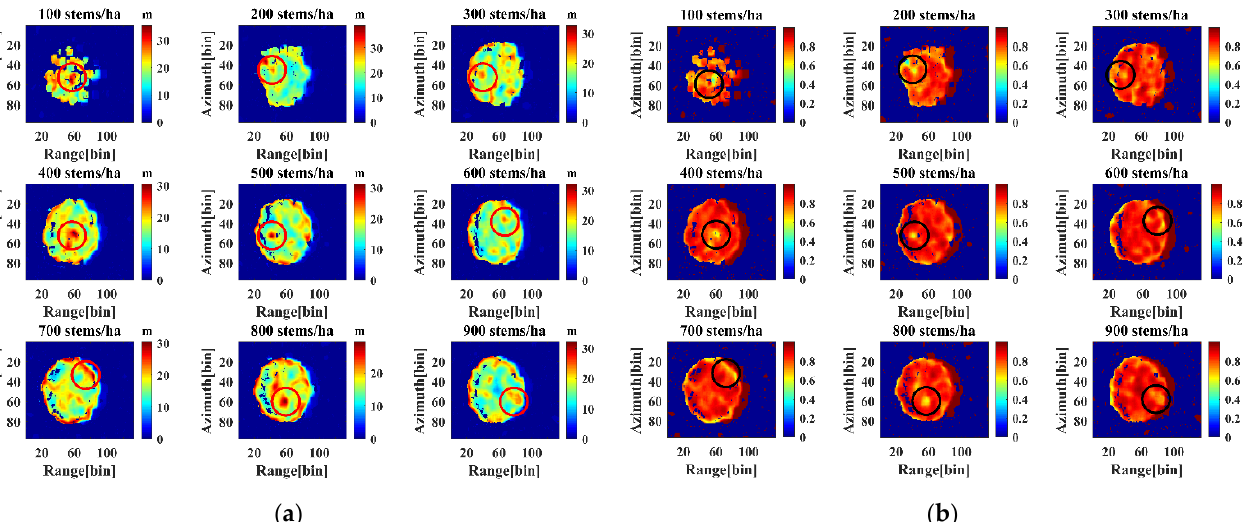
( b ) Figure 9. Relative heights of canopy phase center and ground phase center. ( a ) DEM difference method ( b ) RVoG ground phase method. The orange line represented the SINC inversion method. The overestimation of this algorithm was apparent when the forest density was below 400 stems/ha. However, the RMSE gradually decreased as the forest density increased and always maintained the RMSE at less than 30% of the actual height. The SINC inversion method ignored the effect of ground phase information on the tree height inversion. As a result, the magnitude im ‐ pacted the effectiveness of the SINC inversion method. One of the significant characteris ‐